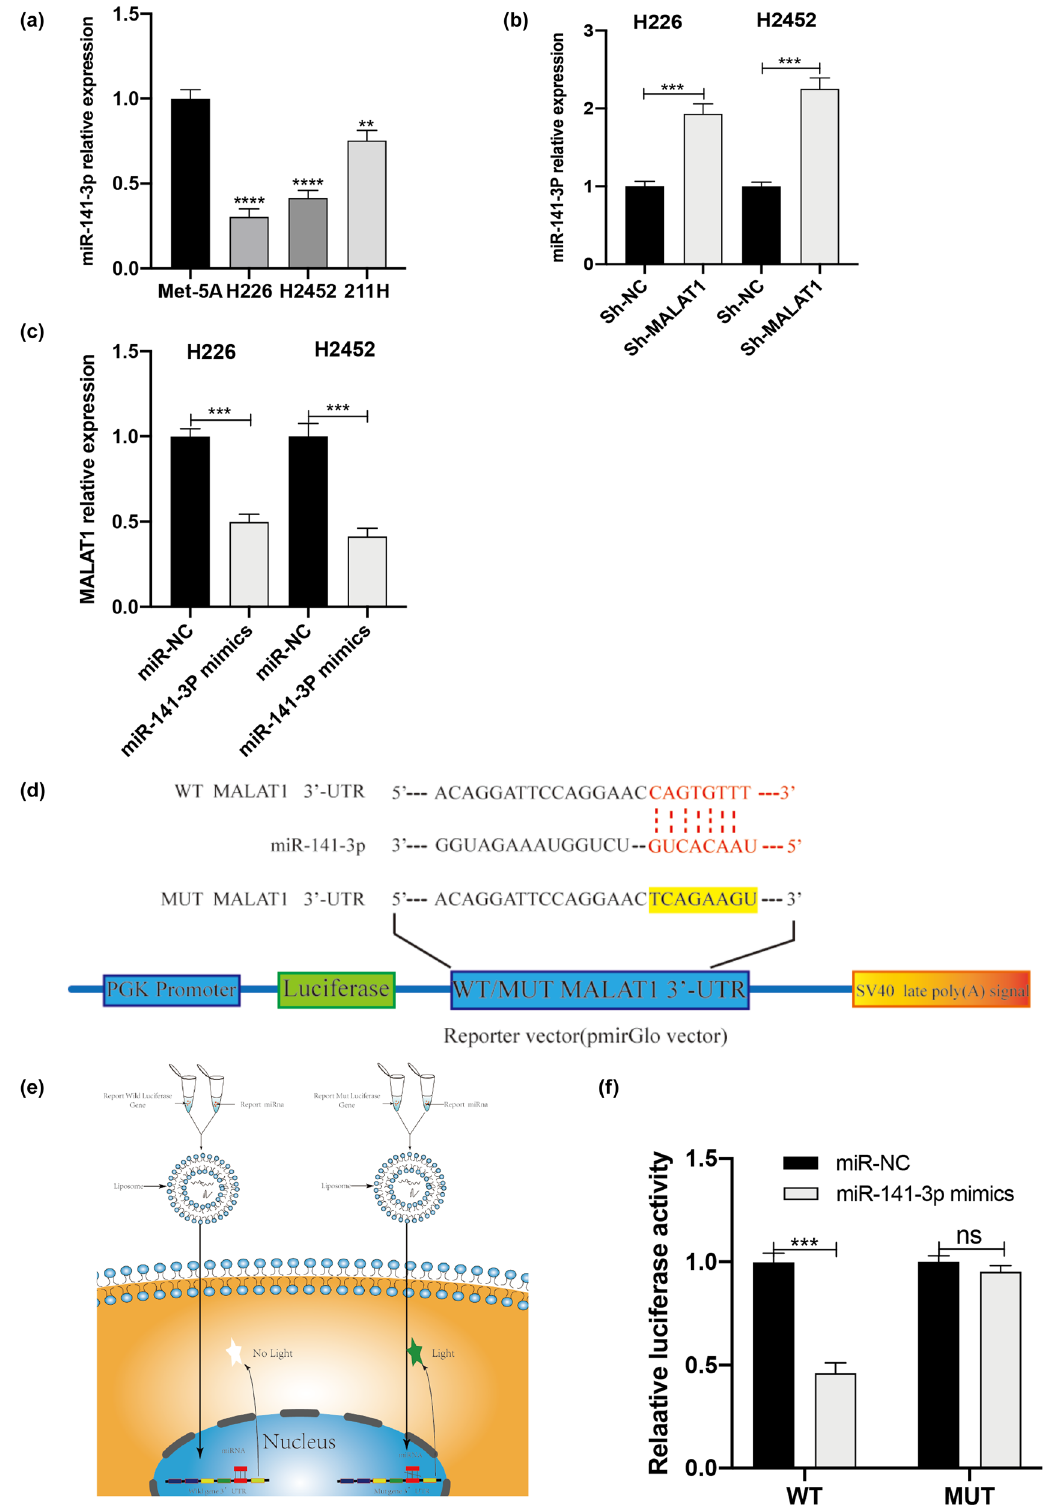
Figure 3: MALAT1 directly binds to the expression level of miR - 141 - 3p and reduces its expression level. ( a ) The expression level of miR - 141 - 3p in human MPM cell lines ( H226, H2452, and MSTO - 211H ) and normal human epithelial cell lines ( Met - 5A ) was detected by RT - qPCR ( ** P < 0.01, **** P < 0.0001 vs Met - 5A group, one - way ANOVA and SNK - Q tests ) . ( b ) The RT - qPCR showed that the expression of miR - 141 -